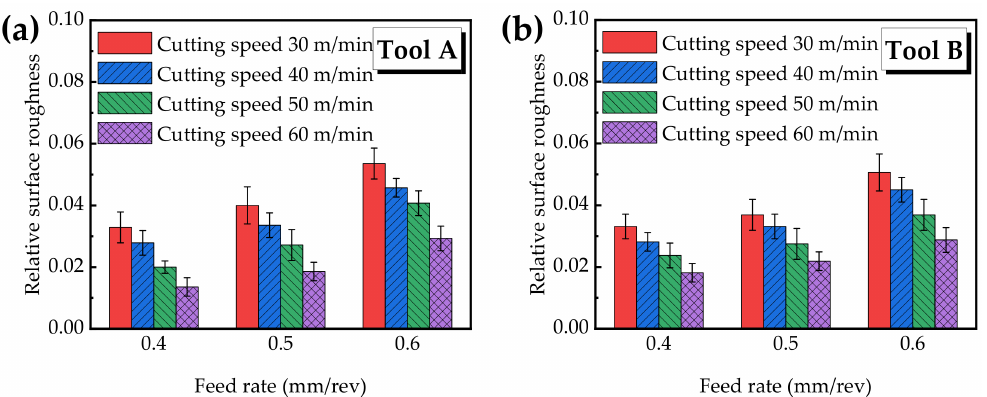
Figure 9. Relative surface roughness versus different cutting